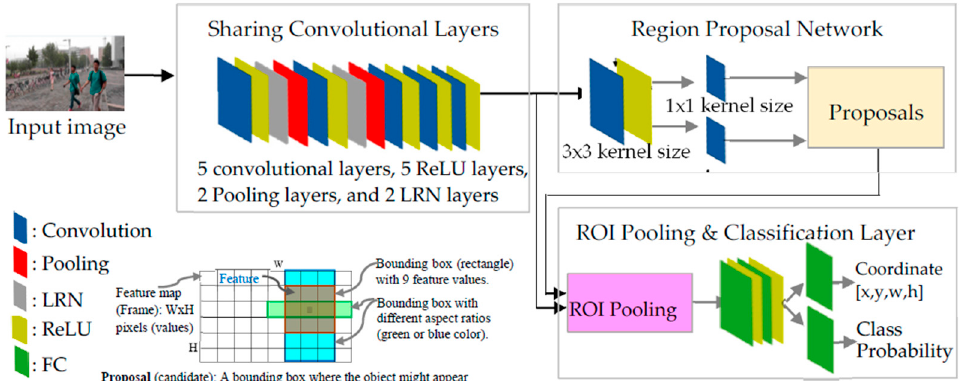
Figure 2. Configuration of the pedestrian detection network composed of three parts: sharing convolutional layers, region proposal network and region of interest (ROI) pooling and classification layers. LRN: local response normalization; ReLU: rectified linear unit; FC: fully-connected layer.